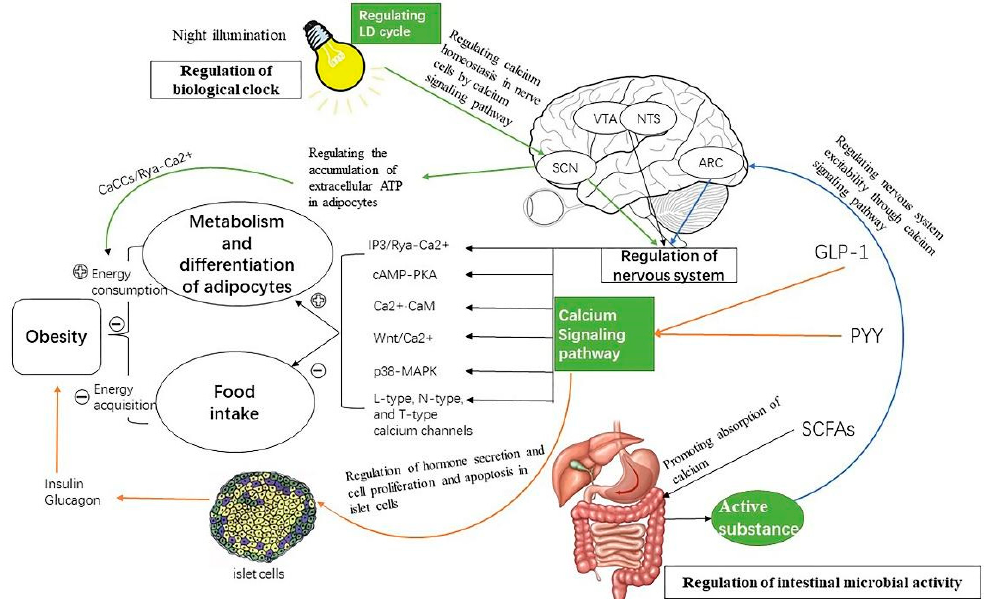
Figure 2. The description of the mechanisms by which the nervous system, the gut microbes, and the circadian rhythms regulate obesity through calcium signaling. This paper summarizes the diagrams of nervous system, light rhythm, and intestinal microorganisms regulating energy consumption and acquisition through calcium signaling pathways. Light changes the activity of SCN neurons by activating calcium signaling pathways, and these signals are transmitted through neurons to brain regions associated with food intake to enhance satiety and inhibit food intake. On the other hand, a signal is transmitted to adipocytes by light, which can promote adipocyte metabolism and heat production by activating DAG-IP3 and cAMP-PKA pathways to increase energy consumption. GLP-1, PYY, and SCFAs secreted by intestinal microorganisms act on the PVN region of the brain, activating feeding-related neurons to enhance satiety and inhibit feeding. IP3-DAG and RTK-Ras-raf-MEK-ERK pathways act on adipocytes to regulate adipocyte metabolism and promote lipid decomposition [25,26]. Directly acting on pancreatic tissue: the proliferation of islet B cells is promoted by many calcium signaling pathways, such as the PLC (phospholipase C)-ERK1 / 2 and the PKC pathways, and the apoptosis of islet B cells is inhibited by the IP3-DAG and the MAPK pathways to ensure that the pancreatic tissue meets the needs of insulin, which may be related to obesity. Signals regulate insulin secretion through the cAMP and the PKA-Syt7 pathways, which are positively or negatively correlated with obesity. Signaling molecule Nesfatin-1 acts on neurons of VTA (ventral tegmental area) and NTS through N-type and T-type calcium channels, enhancing satiety and inhibiting feeding [55,60–64]. Signals are transmitted to adipocytes when there is sympathetic excitation, and the metabolic heat production of brown adipocytes is regulated by cAMP-PKA, TRPV1, TRPA1, and -IP3-DAG pathways to increase energy consumption [83,92–94]. Acknowledgments: The authors are very thankful for Major National Scientific Research Projects